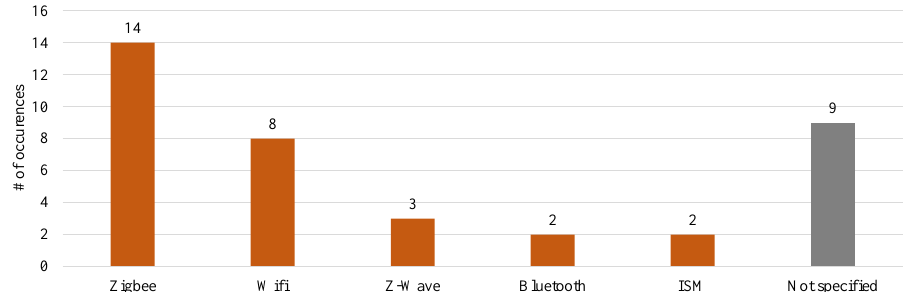
Figure 6. Distribution of wireless sensor networks.